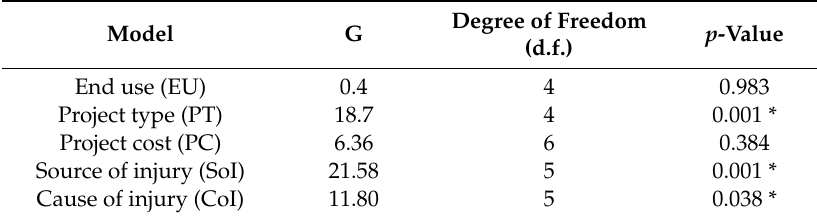
Table 1. Fitting univariate logistic